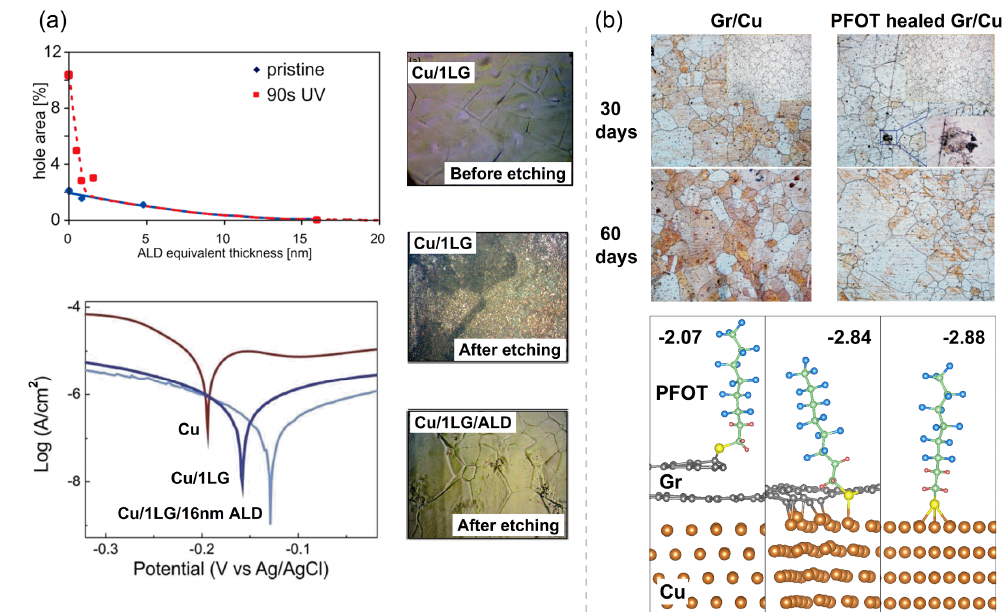
Figure 10. ( a ) Variations in the hole areas with the ALD treatment time for Gr/Cu surfaces with pris- tine and UV-ozone-treated Gr coatings, optical microscope images of 1LG/Cu before CV corrosion and the etched 1LG/Cu and ALD/1LG/Cu, and Tafel plots of bare Cu, 1LG/Cu, and ALD/1LG/Cu. Adapted with permission from Reference [60]. Copyright 2014, American Chemical Society. ( b ) Opti- cal images of Gr/Cu and PFOT-healed Gr/Cu after the 30-day and 60-day ambient corrosion testings, and the atomic structures for the adsorption of PFOT on Gr patch, vacancy edge, and Cu surface, with the adsorption energies (in eV) of PFOT labeled alongside. Adapted with permission from Reference